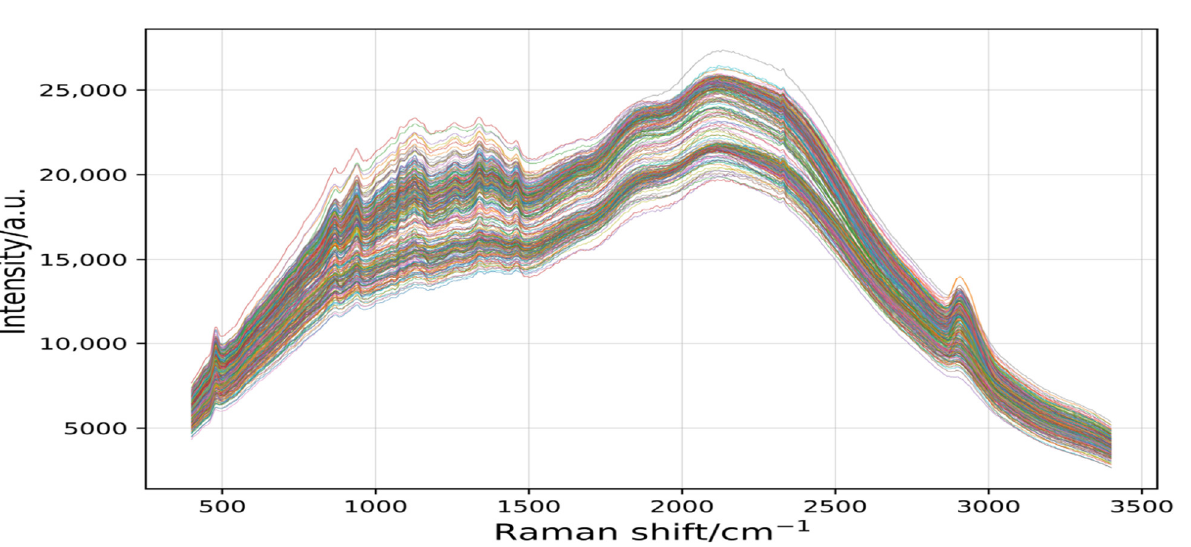
Figure 5. The 245 spectral curves were filtered by the signal.filtfilt function. As shown in Figure 6, this experiment used the difference method to obtain 10 obvi- ous peaks, which were extracted at 480 cm −1 , 865 cm −1 , 941 cm −1 , 1129 cm −1 , 1339 cm −1 , 1461 cm −1 , 1780 cm −1 , 2140 cm −1 , 2330 cm −1 , and 2910 cm −1 . At the same time as the peaks were obtained, small spectral clutters appeared. Therefore, the signal.filtfilt function was used to filter the peaks again.